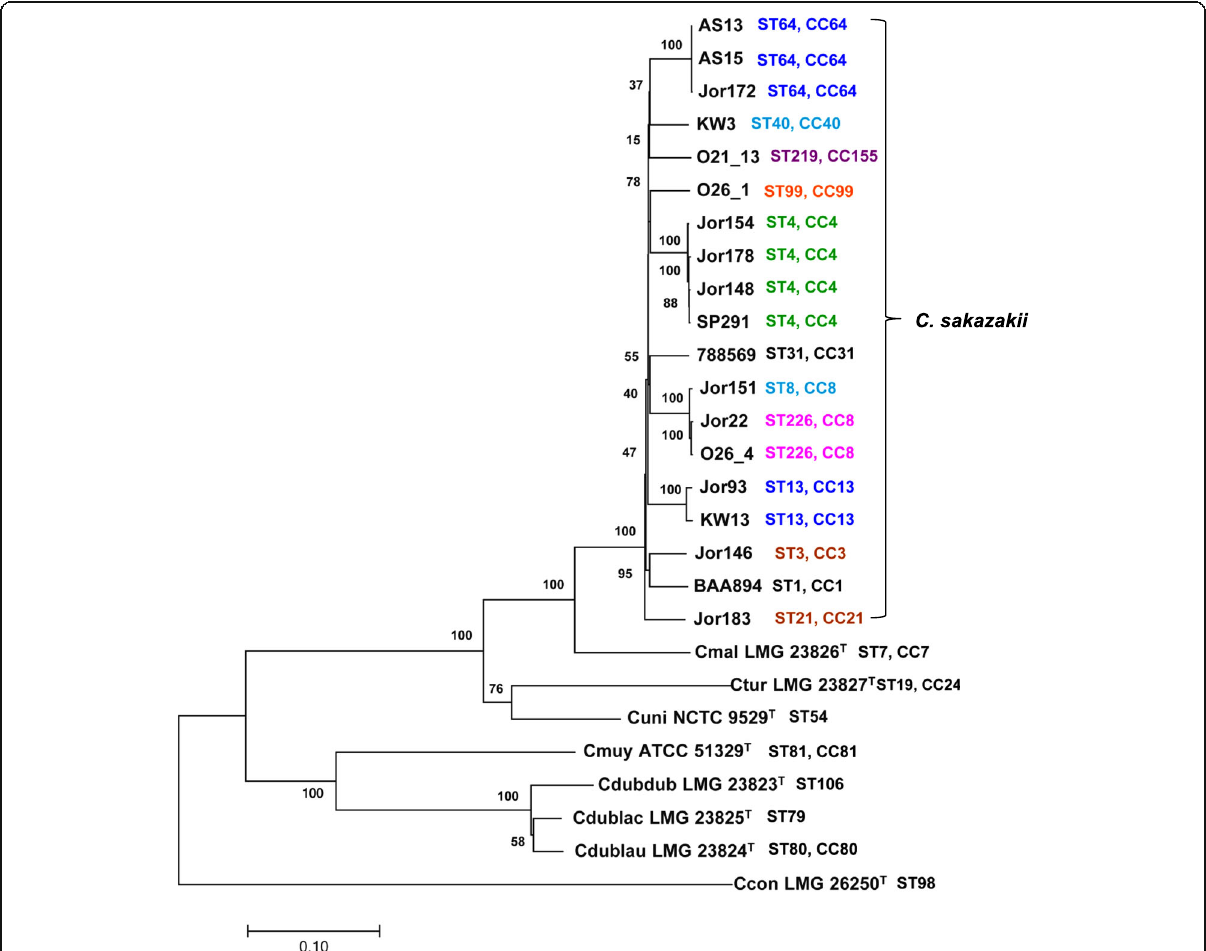
Fig. 2 Phylogenetic analysis of Cronobacter sakazakii strains isolated from spices, compared with eight representative Cronobacter species strains (marked with superscripted ‘ T ’ after each strain ’ s name). NCBI GenBank Accession numbers of type strains: C. malonaticus LMG 23826 T (NZ_CP013940), C. turicensis LMG 23827 T (NC_013282), C. universalis NCTC 9529 T (NZ_CP012257), C. muytjensii ATCC 51329 T (NZ_CP012268), C. dublinensis